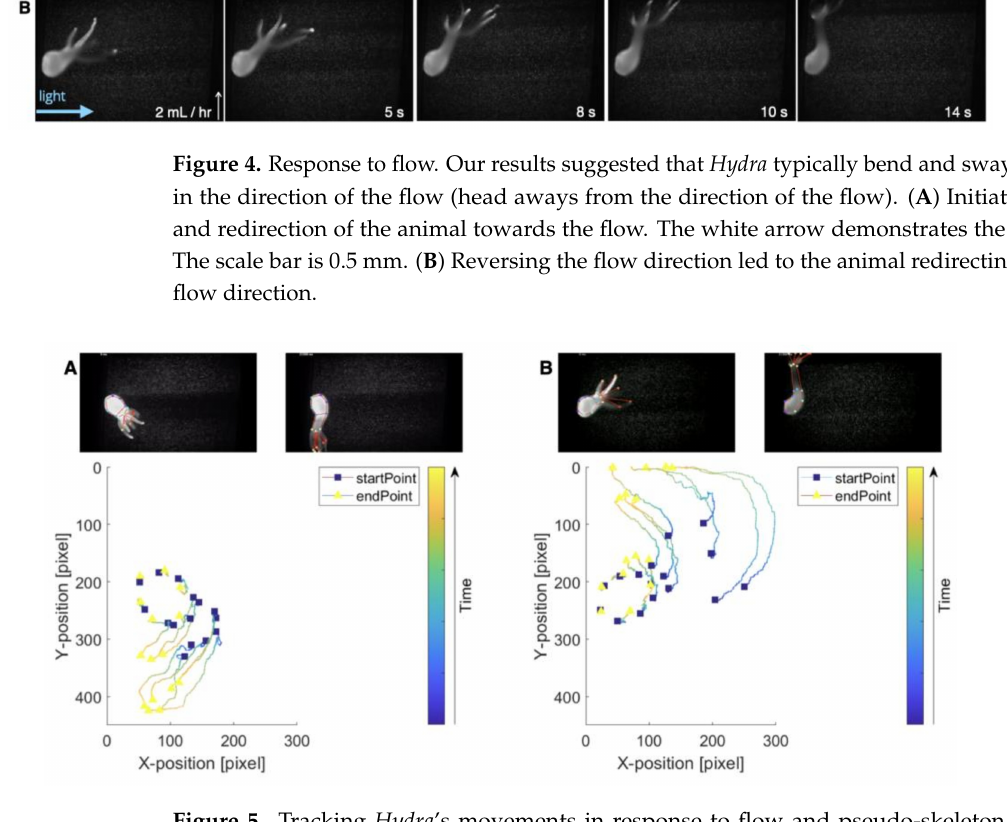
Figure 5. Tracking Hydra ’s movements in response to flow and pseudo-skeleton visualizations. ( A ) Tracking Hydra ’s responses to the initiation of flow. Key anatomical features were identified, a pseudo-skeleton was generated, and the movement of features was tracked over space (here, the units are pixels). ( B ) Response to reversing the direction of flow. In each case, tracking and pseudo- skeletons were generated via DeepLabCut. The integration of SPIM-Flow with pose estimation analysis provided pathways for biomechanics investigations. The starting position is highlighted with a blue square. The final position is highlighted with a yellow triangle. The colors indicate the position in